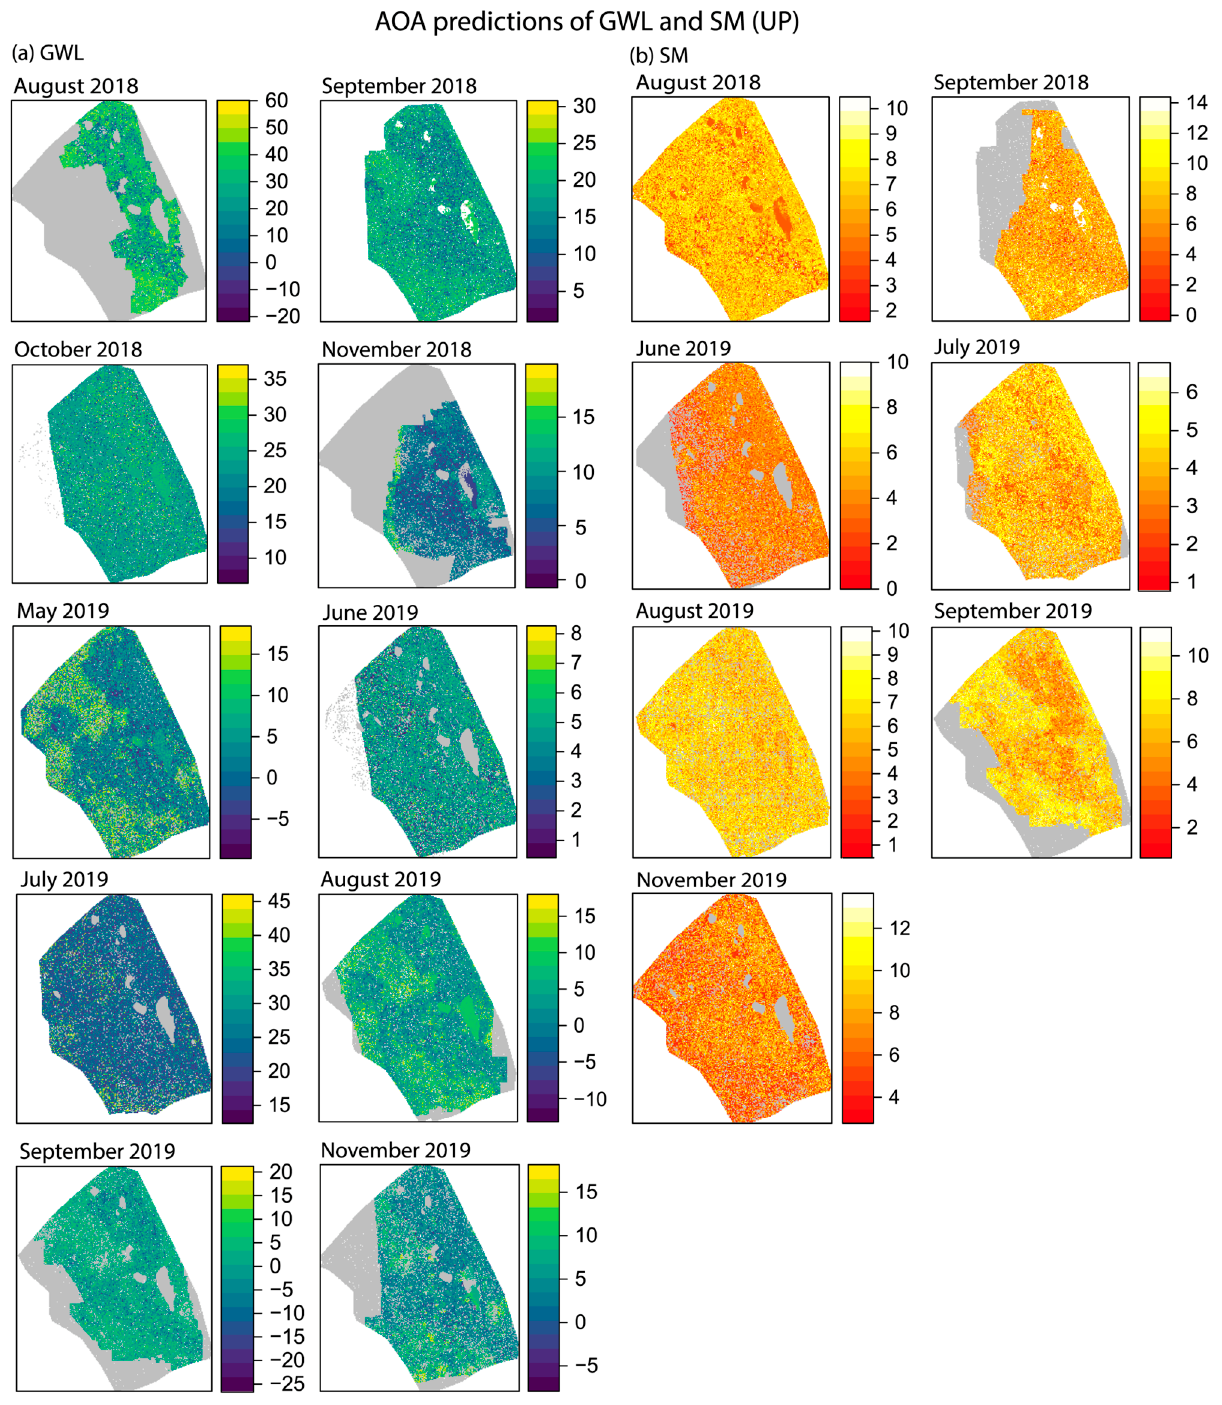
Figure 10. ( a ) GWL (August 2018-November 2019; blue-green) and ( b ) SM (August 2018-November 2019; orange-yellow) predictions of the UP masked by the derived AOA where areas outside the AOA are exposed in gray.